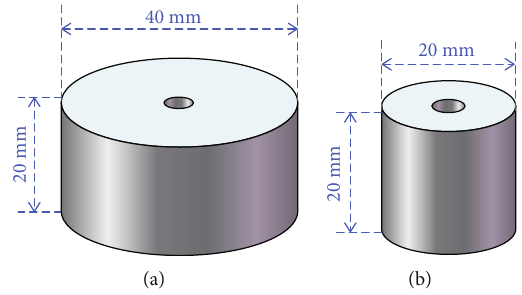
Figure 5: 3D model cylinder: (a) ϕ = 40 mm cylinder; (b) ϕ = 20 mm